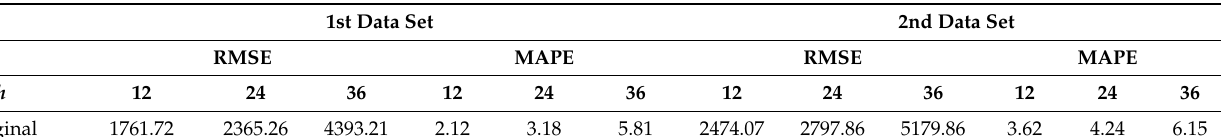
Table 4. RMSE and MAPE of h -step ahead forecast obtained by NNAR model from the original series, KM.N and SSA.KM.N bootstrap